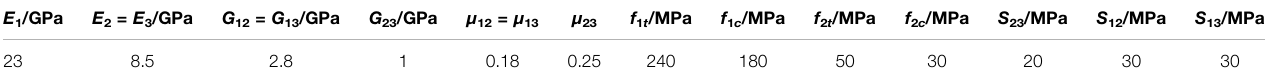
FIGURE A1: Shear failure at the GFRP web of Beam B5-2.